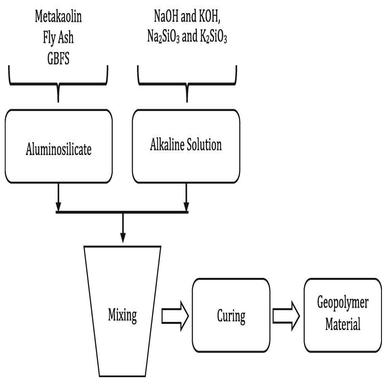
nthesis of Geopolymer cement